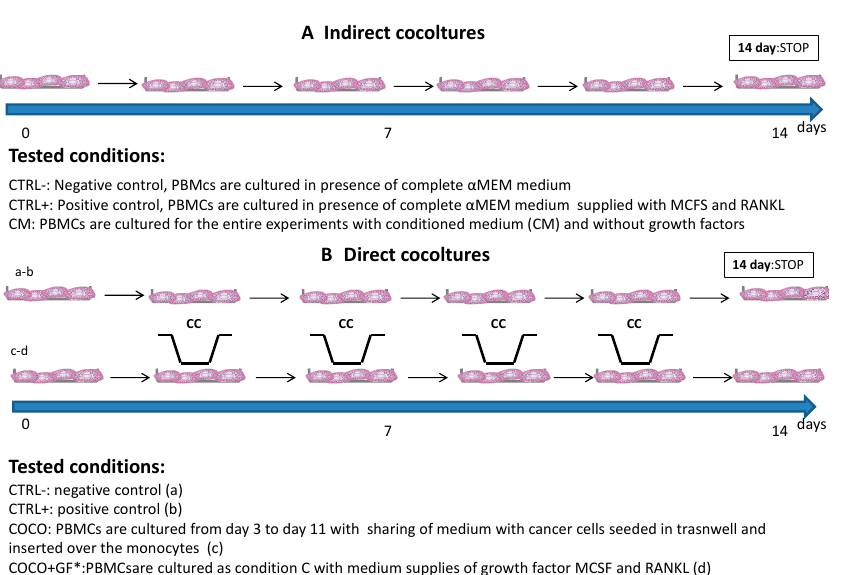
Figure 8. Indirect and direct COCOs: schedules and conditions. Schedule and tested samples of osteoclastogenesis assays are here summarized. PBMCs were differentiated in presence/absence of GFs (CTRL+ and CTRL − , respectively). The influence of CCs on osteoclastogenesis and on drug effects were evaluated with COCOs of CCs and PBMCs in differentiation. We performed indirect COCO ( A ) to optimize the methodology, followed by COCO ( B ) to study the effect of CCs secreted factors on PBMCs and vice versa. * The condition COCO + GF (d) was not tested in all experiments.